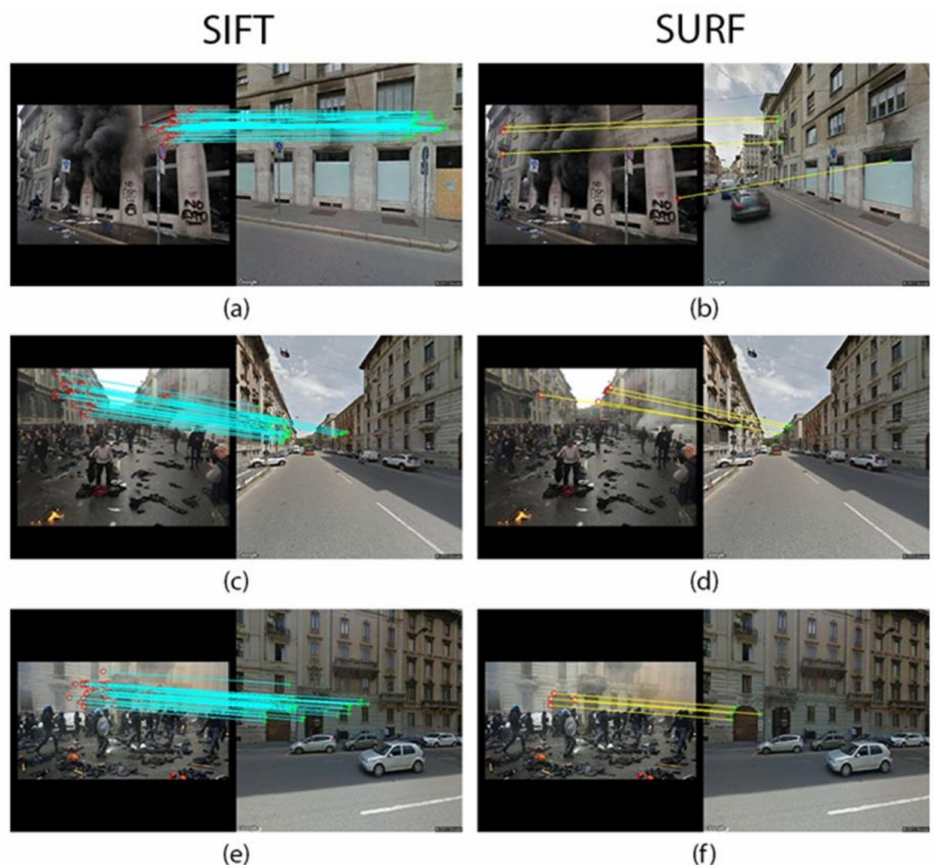
Figure 12. Examples of SIFT and SURF keypoint matching on images posted by users. ( a , b ) SIFT finds 26 correct matches and SURF finds 3 correct matches and one wrong, ( c , d ) SIFT finds 23 correct matches and SURF finds 4 correct matches, ( e , f ) SIFT finds 27 correct matches and SURF finds 4 correct